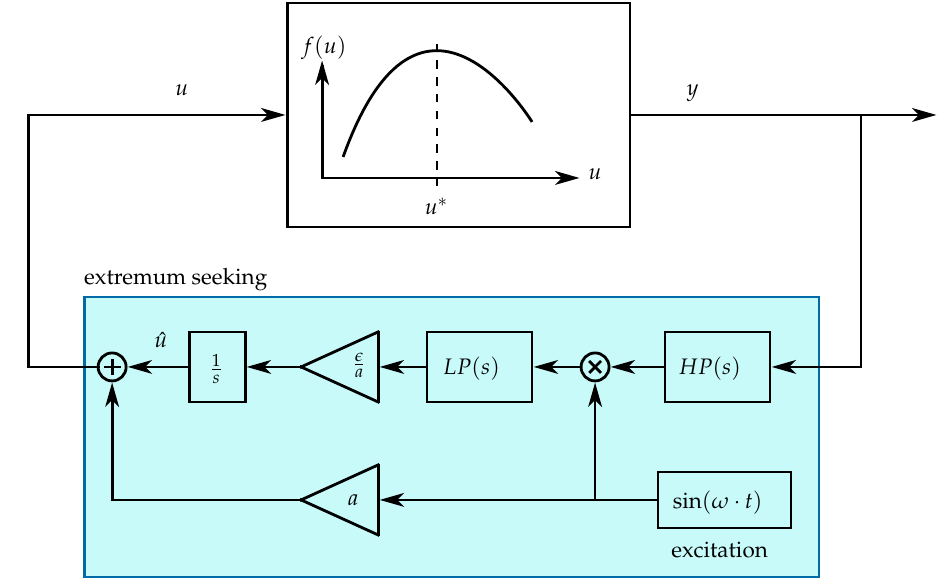
Figure 7. General extremum seeking for a static